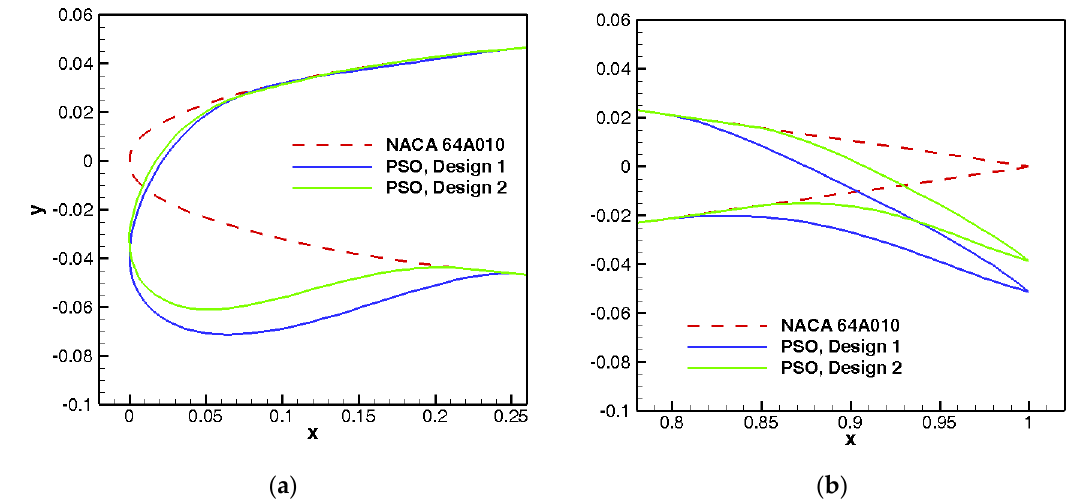
Figure 7. Comparison of the morphing achieved with the aggressive (design 1, four generations) and the conservative (design 2, eight generations) setup using the PSO algorithm. ( a ) LE region and ( b ) TE region.